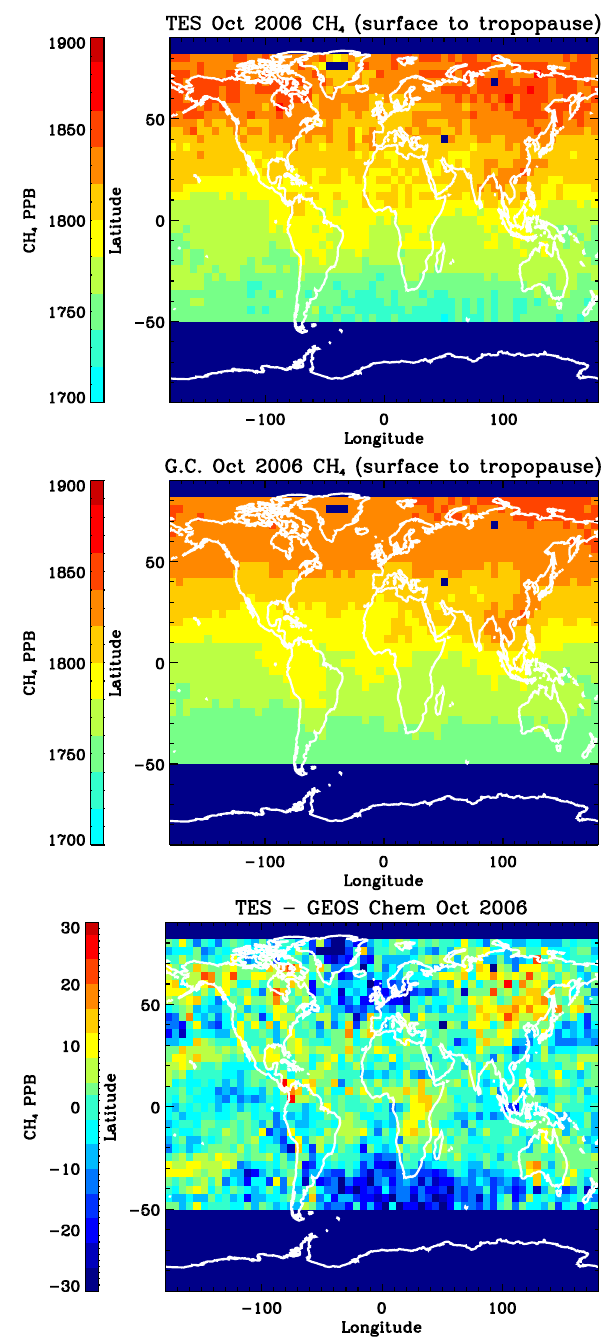
Fig. 6. (a) TES tropospheric CH 4 estimates. The TES estimates have been reduced by 26.3 ppb. (b) Corresponding GEOS-Chem CH 4 estimates adjusted with the TES instrument operator. (c) Dif- ference between TES and